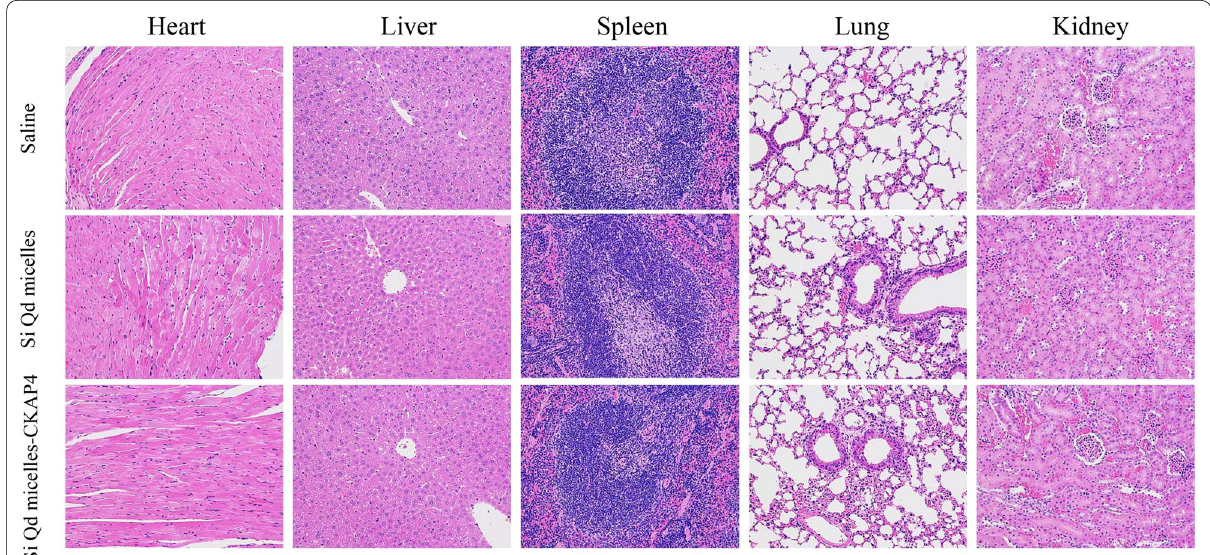
Fig. 7 H&E staining images of the heart, liver, spleen, lungs, and kidneys in tumor-bearing mice injected with saline, Si QD micelles (Si: 4 mg/kg), and Si QD micelles-CKAP4 (Si: 4 mg/kg) for 24 h (magnification: 200 ×